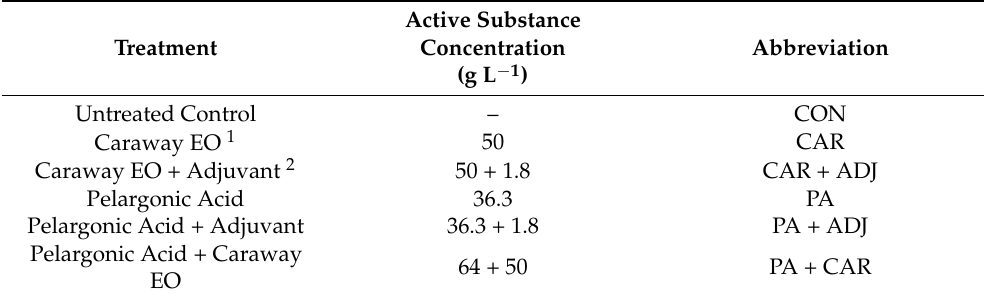
Table 2. Definition of the six different weed control treatments that were applied in both experiments. Active Substance Treatment Concentration Abbreviation (g L − 1 ) Untreated Control – CON Caraway EO 1 50 CAR Caraway EO + Adjuvant 2 50 + 1.8 CAR + ADJ Pelargonic Acid 36.3 PA Pelargonic Acid + Adjuvant 36.3 + 1.8 PA + ADJ Pelargonic Acid + Caraway